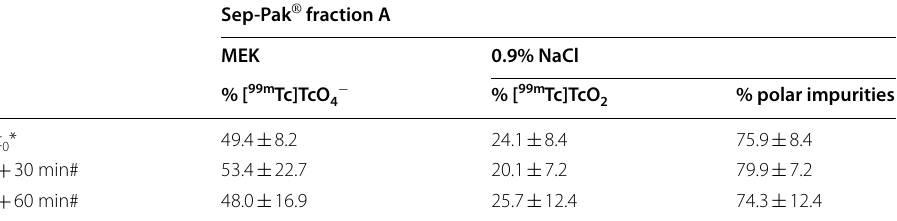
Determined in fraction A, containing hydrophilic impurities not retained on the Sep‑Pak ® cartridge, with TLC SG‑60 stationary phase * n 3 experimental replicates = #